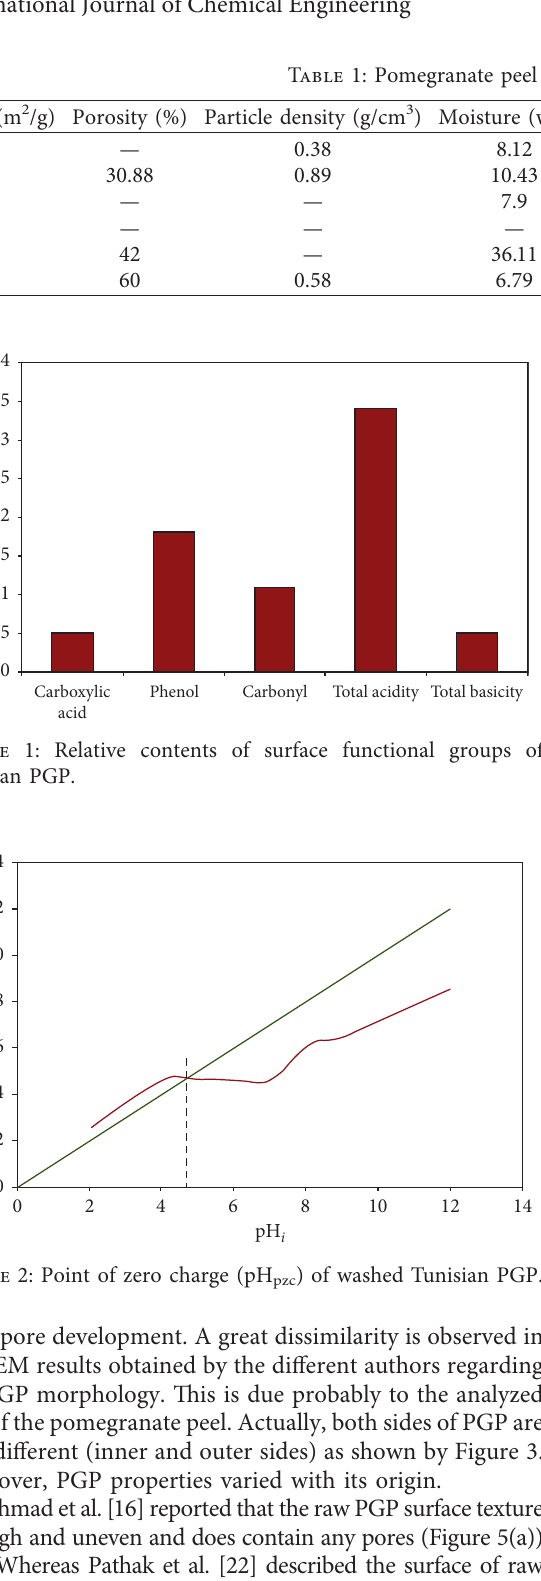
pzc ) of washed Tunisian